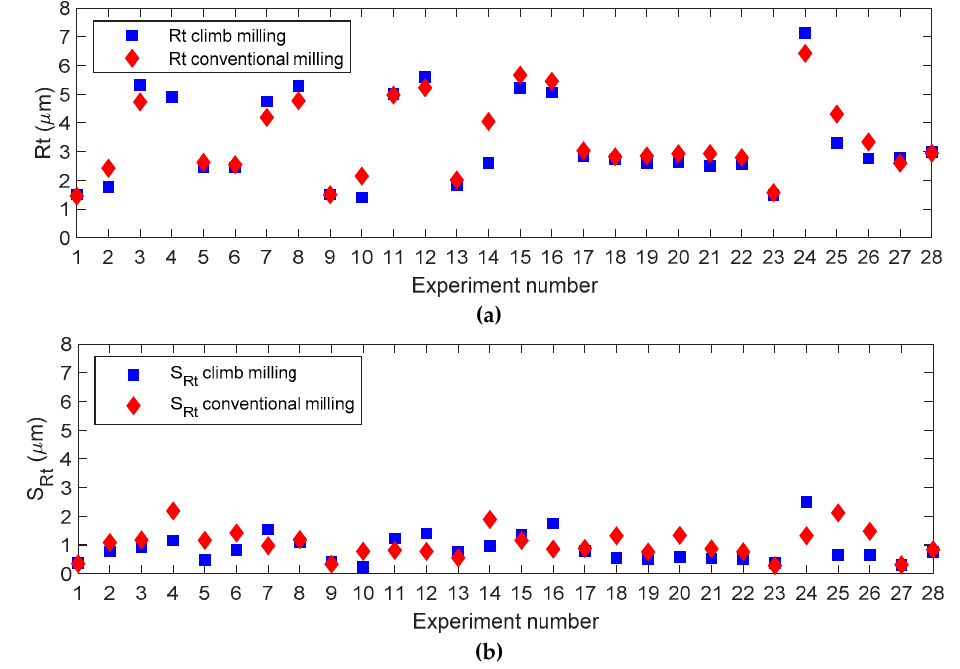
Figure 9. Experimental deviation plots for Rt considering both manufacturing strategies: ( a ) Mean, ( b ) standard deviation.